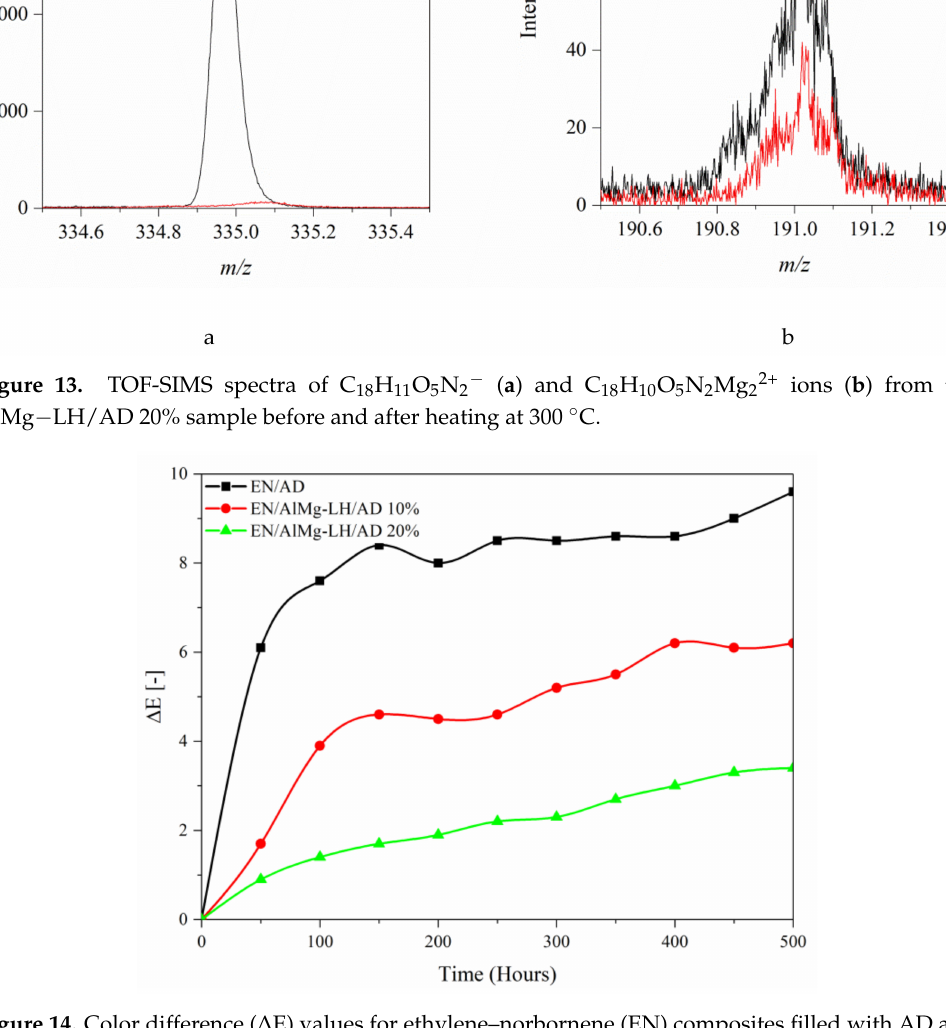
Figure 14. Color difference ( ∆ E) values for ethylene–norbornene (EN) composites filled with AD and AlMg − LH/AD pigments during UV